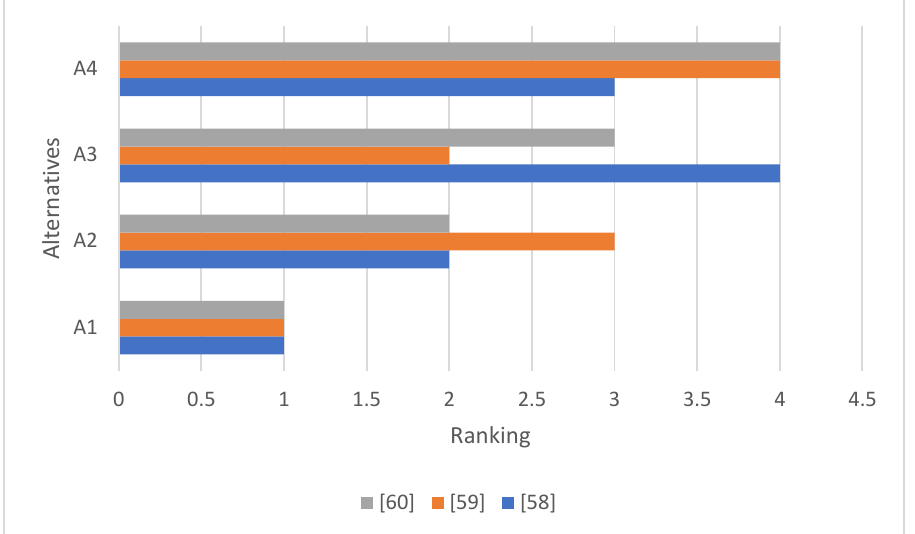
Figure 5. Ranking the alternatives according to [58 – 60].